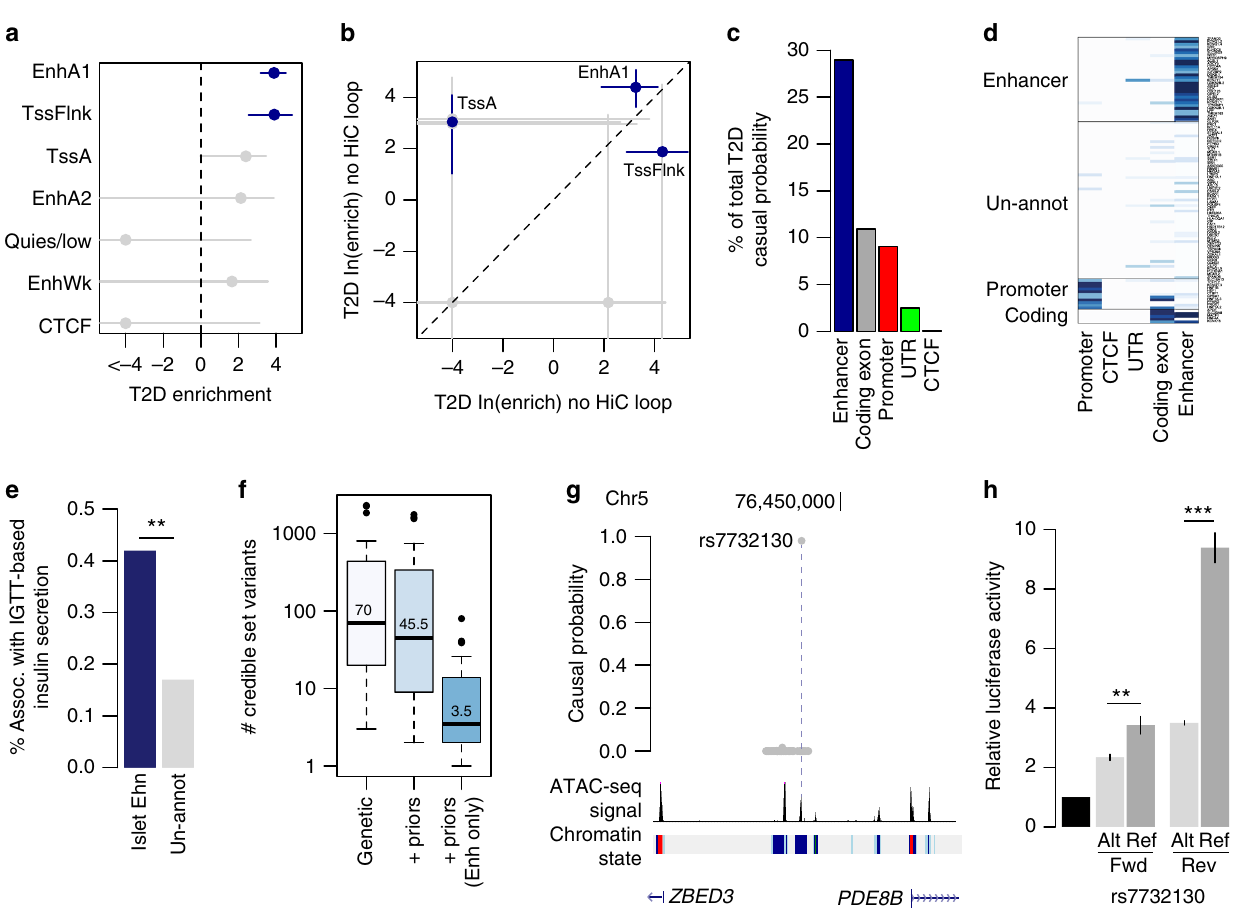
Fig. 3 Type 2 diabetes risk signals map in islet enhancers. a Genetic variants in islet active regulatory elements genome-wide were enriched for T2D risk, with strongest enrichment in active enhancer (EnhA1) elements. Values represent log enrichment and 95% CI, and are colored blue where the 95% CI does not overlap 0. b The effects of variants in active enhancer (EnhA1) and promoter (TssA) elements on T2D risk were stronger among those in chromatin loops, whereas other elements were enriched for T2D outside of loops. Values represent log enrichment and 95% CI, and are colored blue where the 95% CI does not overlap 0. c Over 30% of the total causal probability across 107 known T2D risk signals mapped in islet enhancer elements. d Clustering of known T2D signals based on islet and coding annotations identi fi ed 30 signals with likely causal variants in islet enhancers. e A signi fi cantly higher percentage of T2D islet enhancer signals were associated with IGTT-based insulin secretion phenotypes than un-annotated T2D signals (Chi-square ** P < 0.001). f Number of variants in the 99% credible sets for the 30 T2D islet enhancer signals based on genetic fi ne-mapping alone (genetic), genetic fi ne-mapping, including functional priors ( + priors). g T2D causal variant rs7732130 at the 5q13 locus near ZBED3/PDE8B mapped in an islet active enhancer. h rs7732130 has allelic effects on enhancer activity in the islet cell line MIN6 ( N = 3), where the T2D risk allele and reference (ref) G has higher activity than the alternate (alt) allele A. Values represent mean and SD. T -test ** P < 0.001, *** P < 0.0001. Boxplots show the median, and third and fi rst quartiles. Source data are provided as a source data fi loci, we identi fi ed an additional 127 loci genome-wide where fi ne- (19/24) were predicted to disrupt a TF footprint (Supplementary mapping identi fi ed a putative T2D risk variant that overlapped an Data 7). Among putative T2D loci, we identi fi ed 20 additional islet enhancer and ATAC-seq site from >1 sample (Supplemen- variants with signi fi cant allelic imbalance (FDR < 0.1) (Supple- tary Fig. 3c, Supplementary Data 1, and Supplementary Data 8 ;